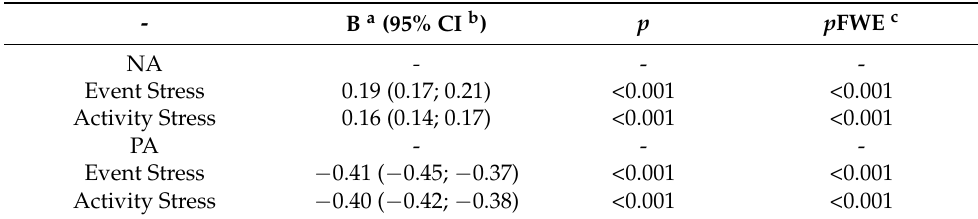
Table 2. Association between stress and affect. -